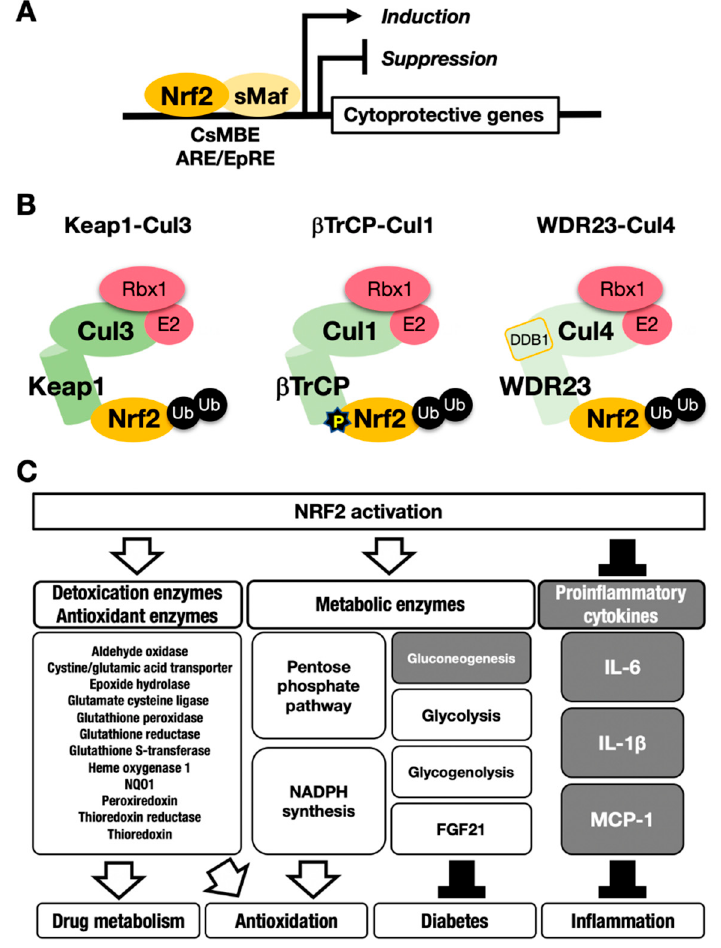
Figure 1. The NRF2-sMaf heterodimer regulates cytoprotective gene expression through the CNC- sMaf-binding element (CsMBE) motif. ( A ) NRF2 forms a heterodimer with sMaf and binds to the CsMBE motif in the nucleus, which is classically referred to as an antioxidant responsive element (ARE)/electrophile responsive element (EpRE) motif. NRF2 positively regulates genes encoding detoxicating enzymes and antioxidative enzymes and negatively regulates genes coding for proin- flammatory factors. Ub, ubiquitin. P, phosphorylation. ( B ) The combination of an E3 ligase and the adaptor for the degradation of NRF2 through ubiquitination: KEAP1–Cul3, β TrCP–Cul1 and WDR23-Cul4 complexes. ( C ) NRF2 target genes responsible for the drug metabolism, antioxidation, antidiabetes and anti-inflammation. White arrows indicate induction; black bars indicate